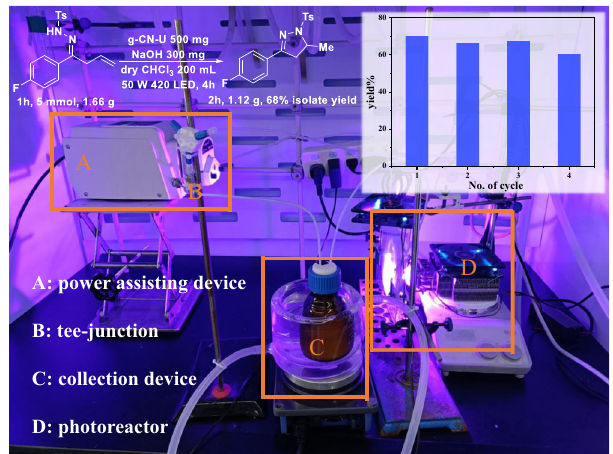
Fig. 6 | Gram-scale reaction with a continuous- fl ow setup and recycling of the photocatalyst. Reaction conditions 1h (5mmol, 1.66g), NaOH (300mg), g-CN-U